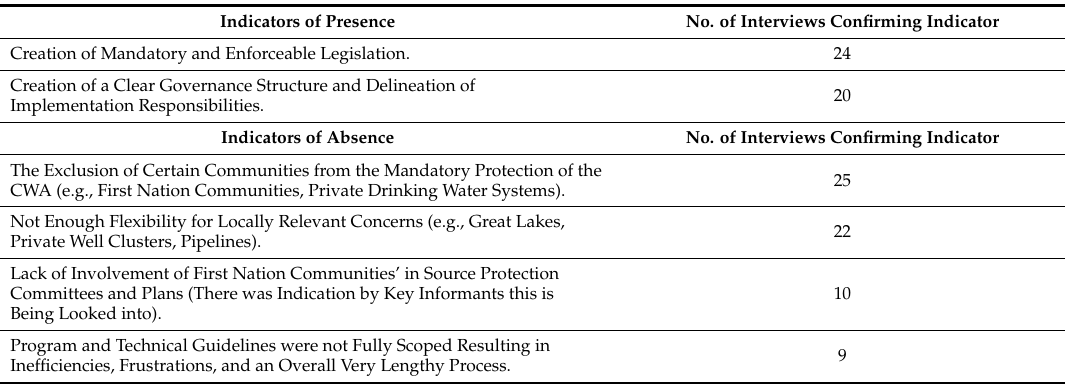
Table 3. Key Findings for Institutional Capacity.